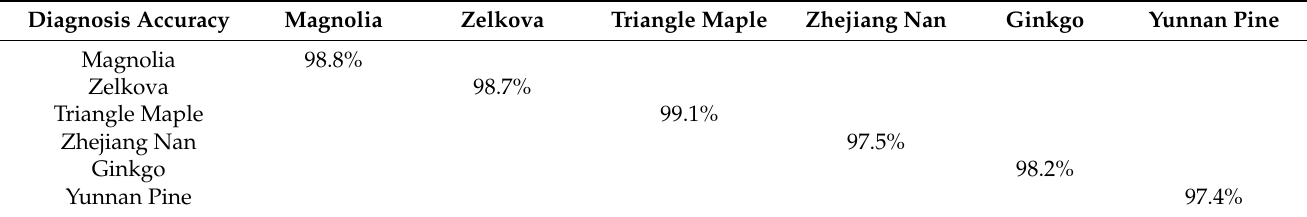
Table 13. Confusion matrix of the results of the standing timber